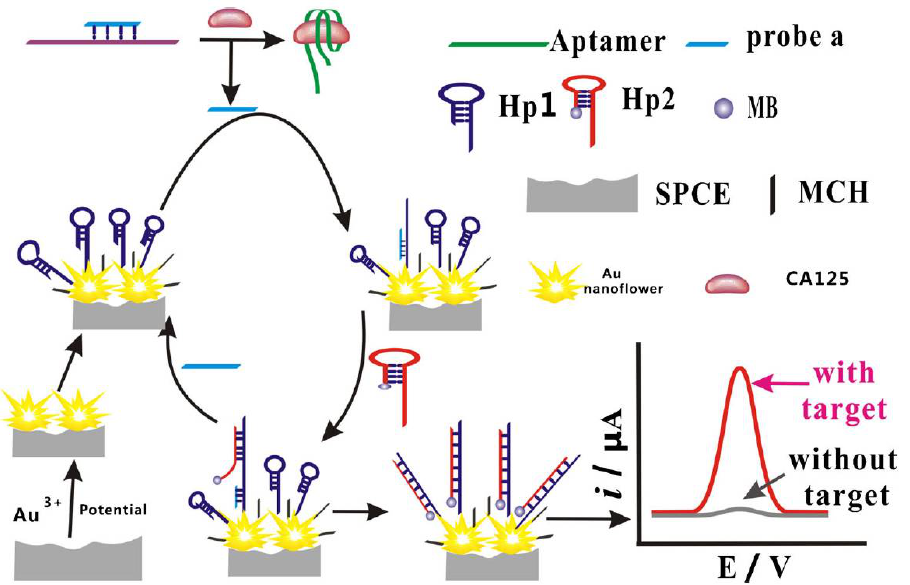
Figure 6. Schematic representation of the stepwise preparation of the biosensor for CA125 detection based on the use of flower-like gold nanostructures and target-triggered strand displacement amplification [160]. Copyright (2019) Springer, reprinted with permission.